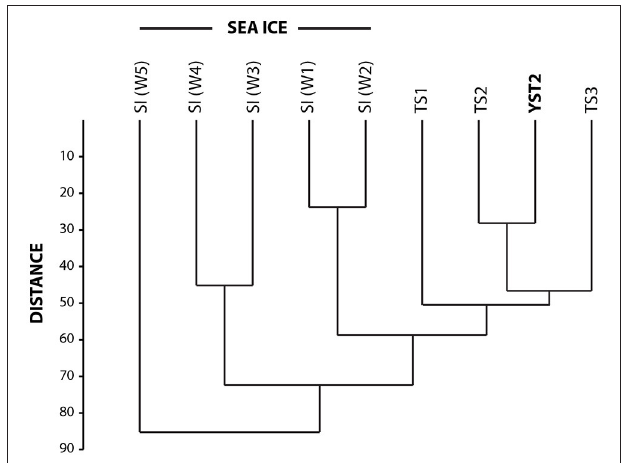
FIGURE 6 | Dendrogram resulting from the cluster analysis. SI, sea-ice sample; TS, sediment trap samples; and YST2, surface sediment